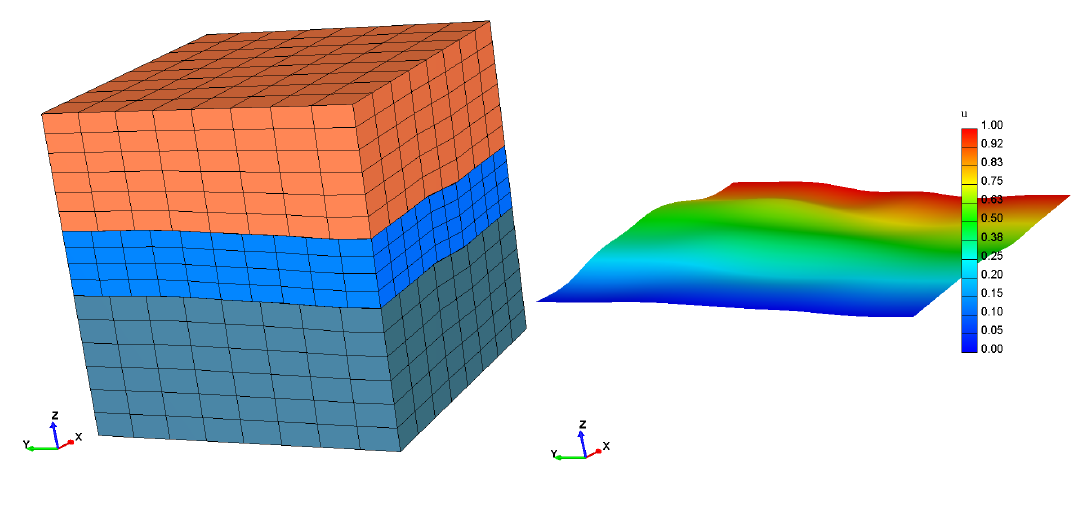
Figure 2. Nonconforming discretization subdomains and one mortar surface.